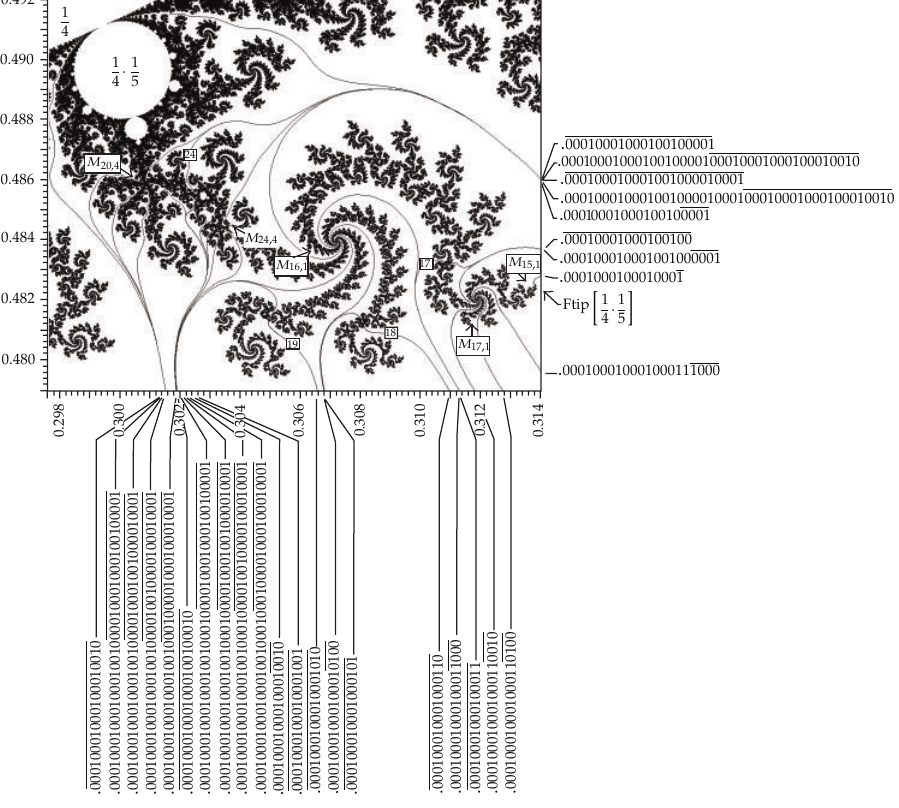
Structural HCs of a subshrub are characterized by the